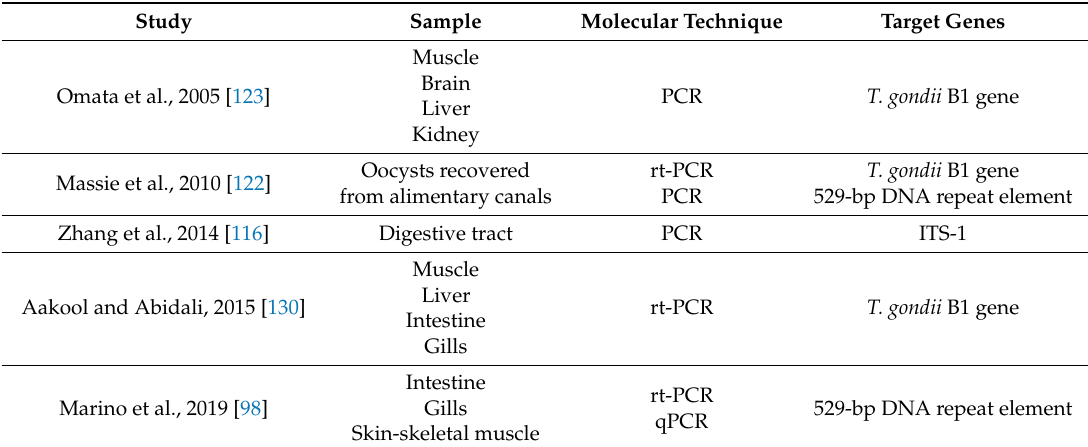
Table 8. Comparative table on the molecular methods (technique and target genes) used for identifying Toxoplasma gondii in fish